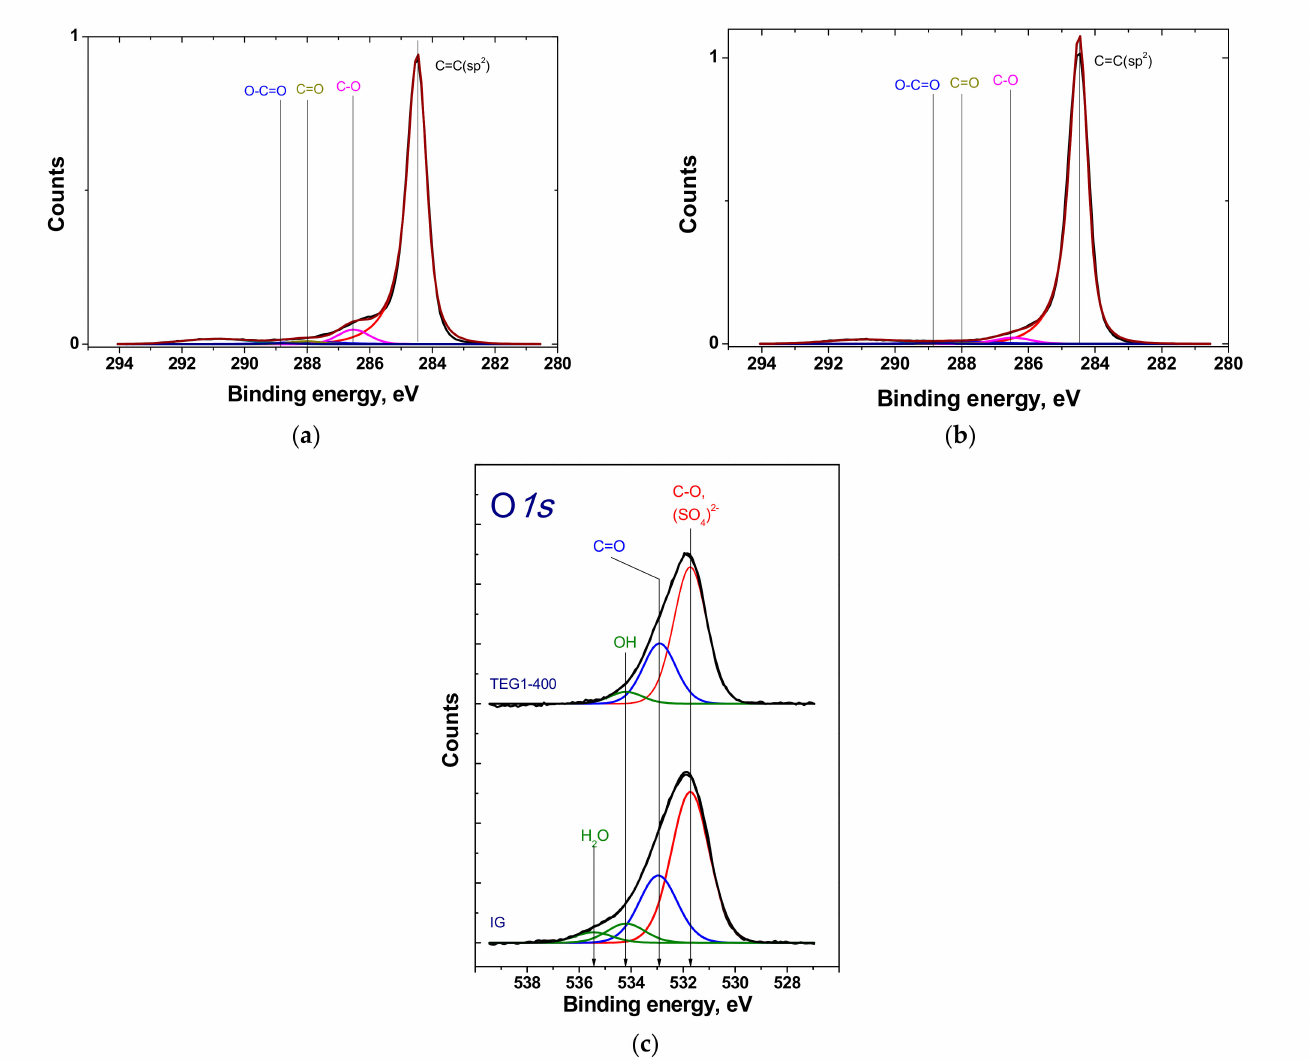
Figure 10. C1s XPS spectra of intercalated graphite ( a ) and TEG1-400 sample ( b ); O1s spectra of intercalated graphite and TEG1-400 sample ( c